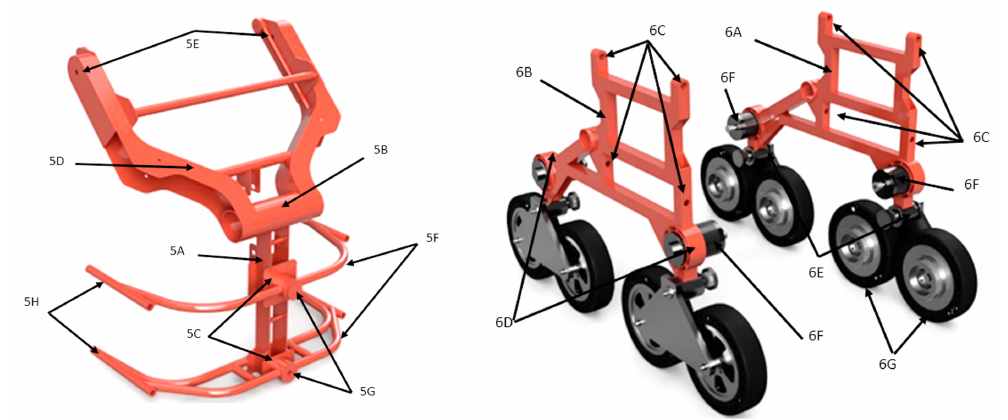
Figure 10. Seated-standing mechanism. ( Left ) Coronal, ( Right )